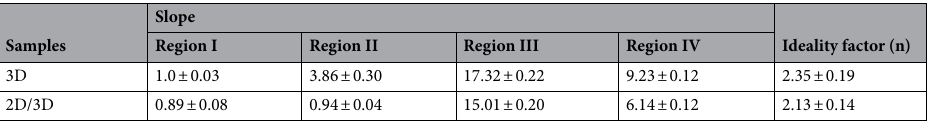
Table 2. The slopes obtained from the double-logarithmic scale graphs of the 3D and 2D/3D samples under dark. The value of the slope represents the conduction mechanism that happened at the different applied potential within the V oc range. The ideality factor "n" represents the diodic quality of the devices.